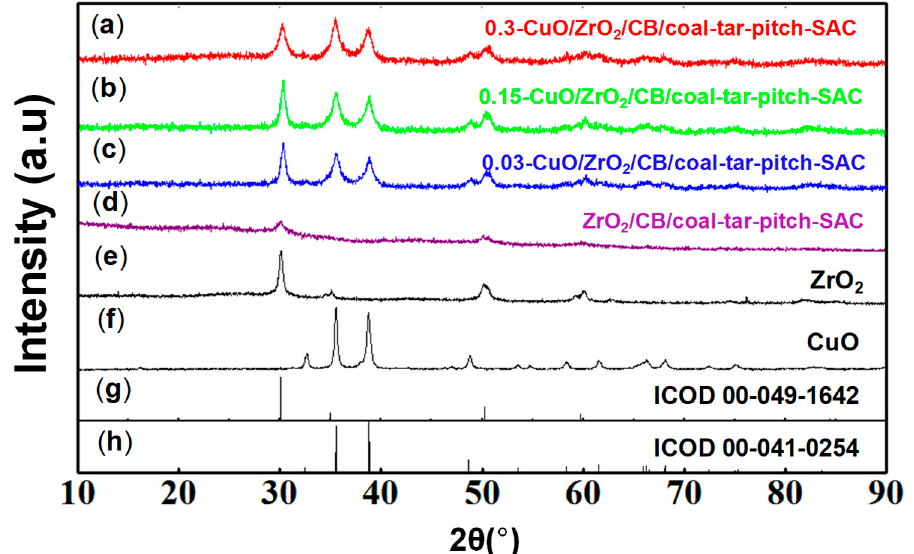
Figure 2. XRD results of CuO/ZrO 2 /CB/coal-tar-pitch-SAC materials ( a – c ), ZrO 2 /CB/coal-tar-pitch-SAC; ( d ), ZrO 2 ; ( e ), CuO; ( f ), standard of ICOD 00-049-1642 of ZrO 2 ; ( g ) and standard of ICOD 00-041-0254 of CuO ( h ).